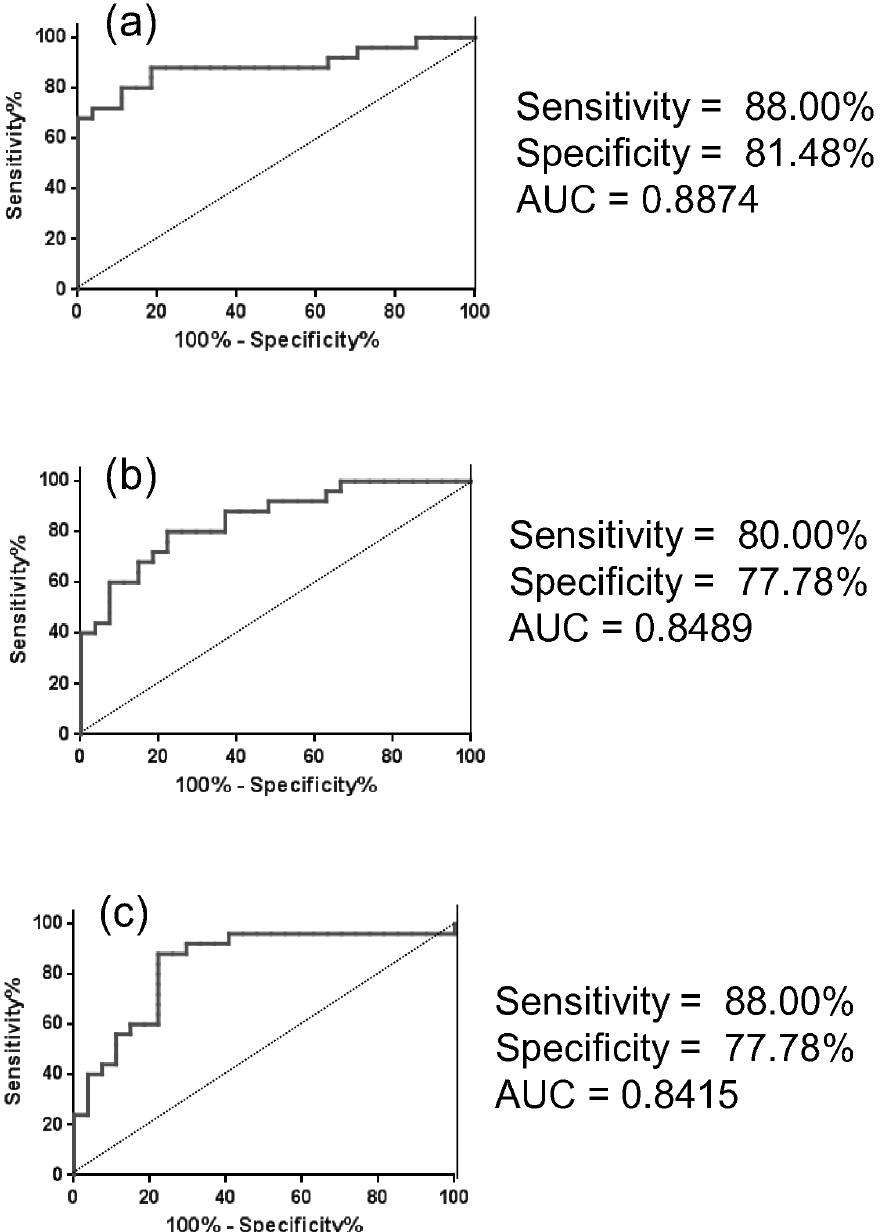
Figure 2. Receiver operating characteristic (ROC) curve analyses of c -GluCys (a), lenoleic acid (b), and D-lactate (c).